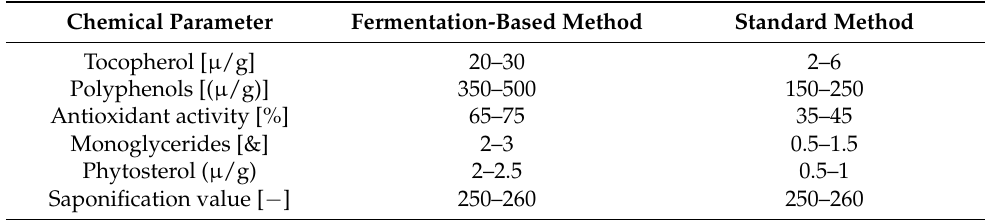
Table 1. Quality characteristics of fermentation-based coconut oil and standard